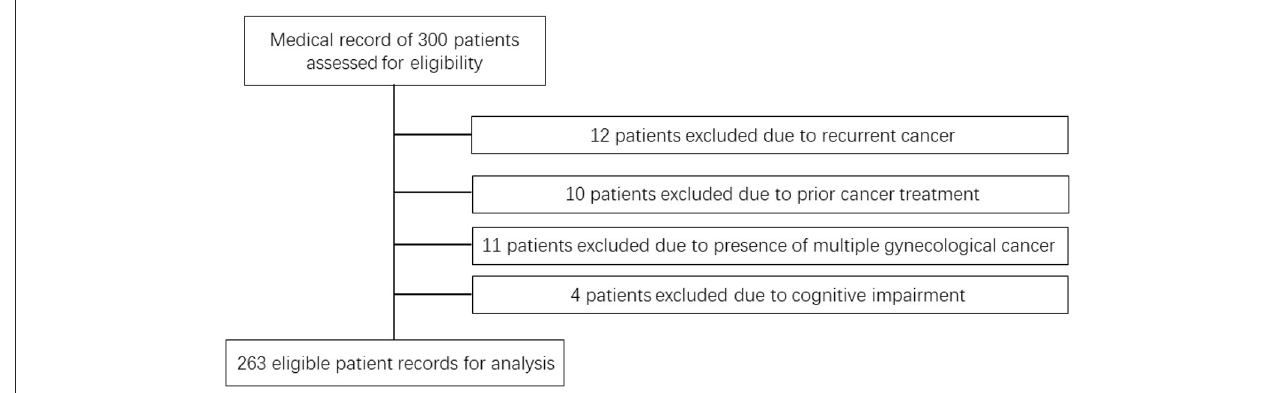
FIGURE 1 | Patient selection flowchart.